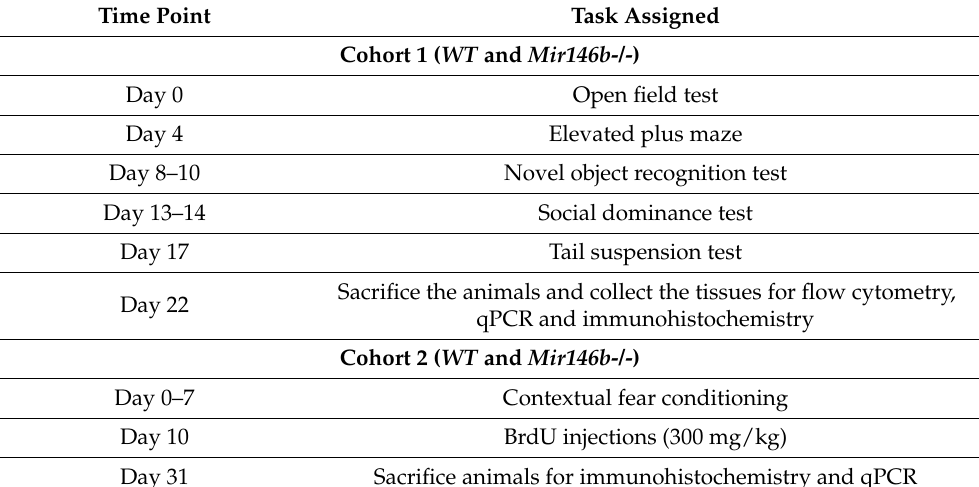
Table 1. Sequence of the